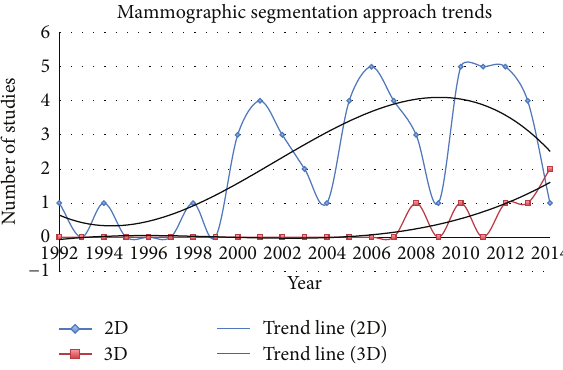
Figure 8: Polynomial based trend lines for both area and volu- metric based mammographic density/parenchymal segmentation approaches from 1992 to 2014. Note that the (blue) 2D trend line shows harmonic (e.g., interval peaks) behaviour which may be because a surge of manuscripts was submitted for publication at the same years (e.g., biannual) as the major breast imaging related